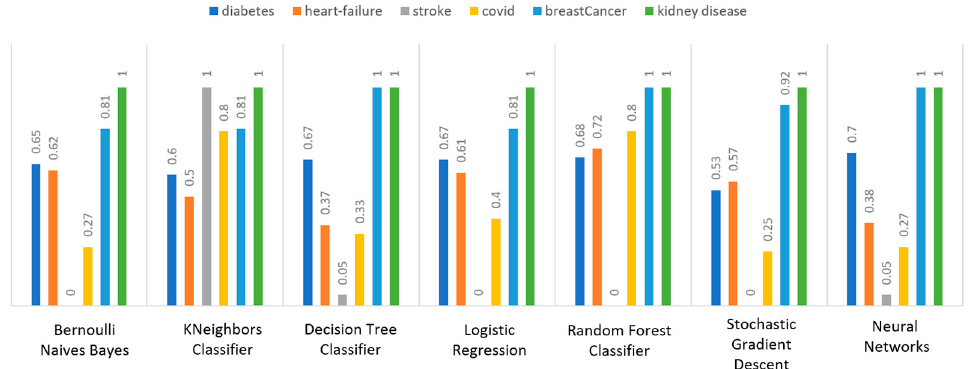
Figure 14. Specificity results of ML models for each use case.